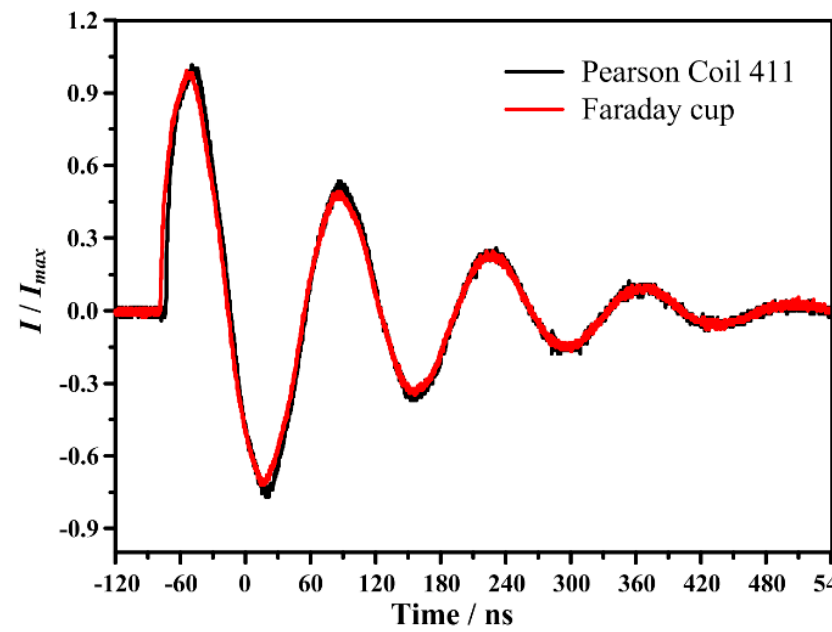
Figure 5. Calibration waveform of Faraday cup.